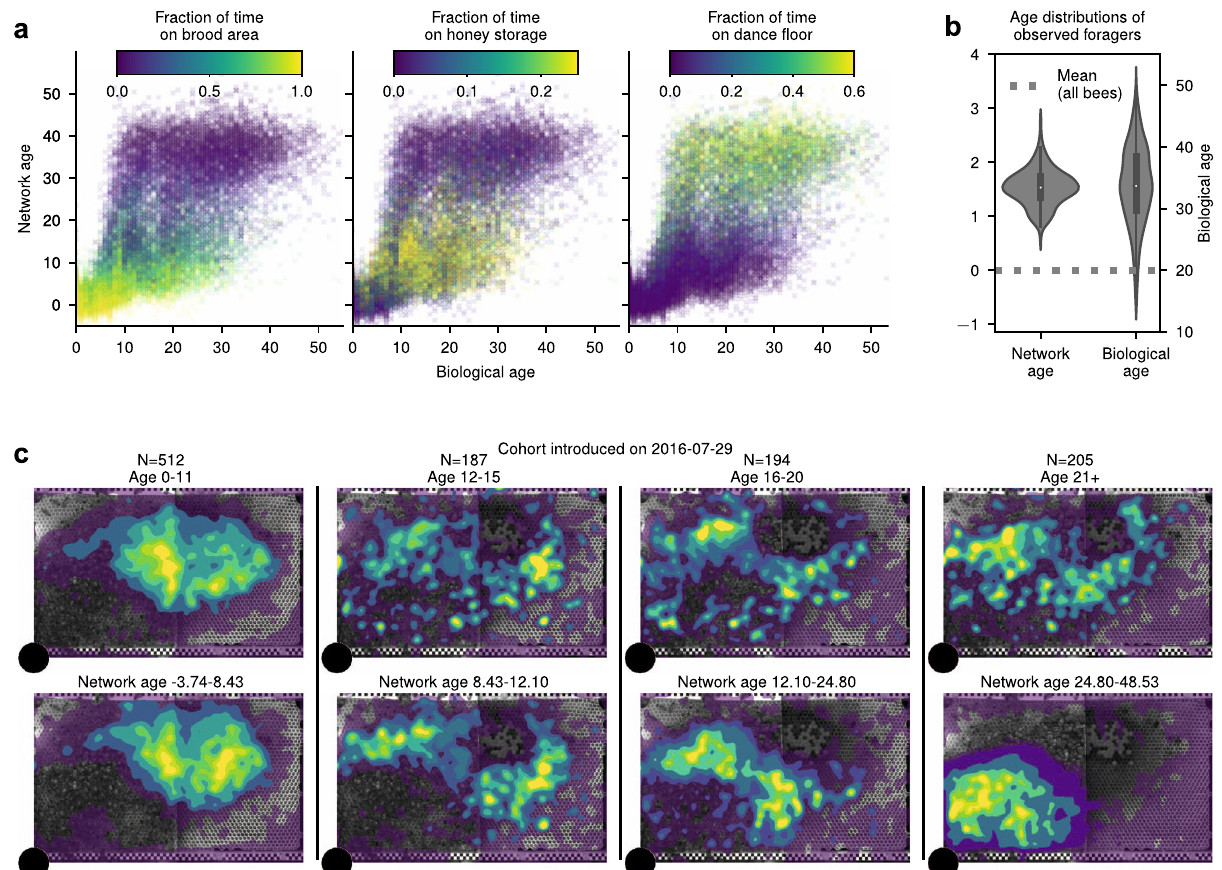
Fig. 2 Network age is an accurate descriptor of task allocation. a The proportion of time spent on task-associated locations in relation to biological age and network age with each cross representing one individual on one day of her life. For a given value on the y -axis (network age) colors are more consistent than for a given value on the x -axis (biological age). b Z -transformed age distributions for known foragers visiting a feeder ( N = 40 observed individuals). The variance in biological age is greater than the variance in network age (boxes: center dot; median; box limits; upper and lower quartiles; whiskers, 1.5× interquartile range). Corresponding biological ages are also shown on the right y -axis (original biological age: 34.2 ± 7.9; original network age: 38.3 ± 4.6; mean ± standard deviation). c Spatial distributions of an example cohort over time (bees emerged on 29 July 2016, 64 individuals over 25 days), grouped by biological age (top row) versus network age (bottom row). Note how network age more clearly delineates groups of bees than biological age, with bees transitioning from the brood nest (center of the comb), to the surrounding area, to the dance fl oor (lower left area). The shaded areas depict density percentiles (brightest to darkest: 99%, 97.5%, 95%, 80%, 70%,